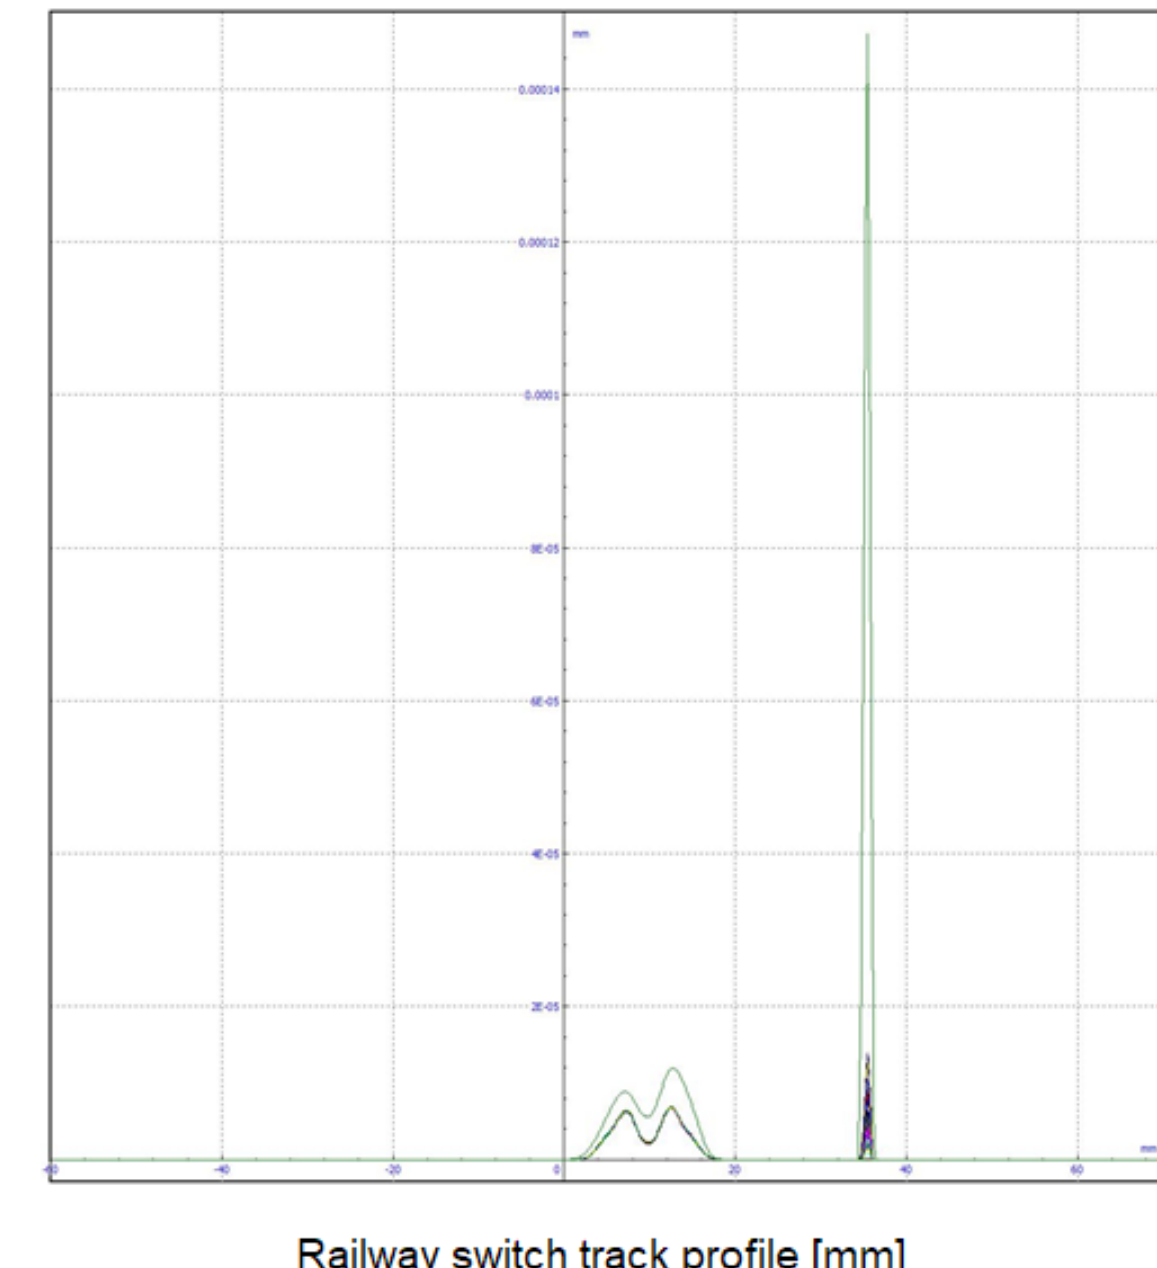
Figure 40. Wheel wear for a straight track without a turnout with constant stiffness obtained at 200 km/h. The maximum wear value is above 0.00014 mm.